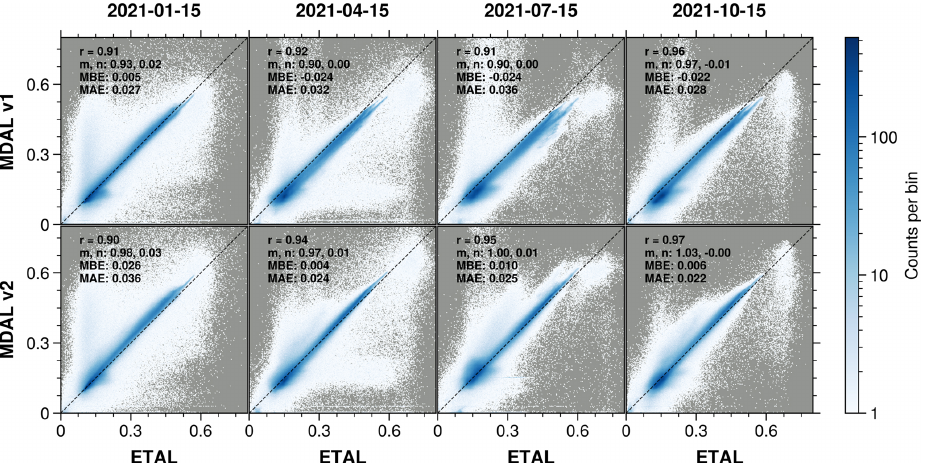
Figure A3. Two-dimensional histogram highlighting correlation between MDAL v1 (top) and v2 (bottom) and ETAL, for BB-DH albedos for January, April, July and October 2021 (15th of each month). r is Pearson’s correlation coefficient; m and n are the slope and intercept of a least-squares fitted linear regression line. The color scale is normalized to logarithmic scale for better visibility. The dashed line is the line of perfect correlation ( m = 1, n = 0).